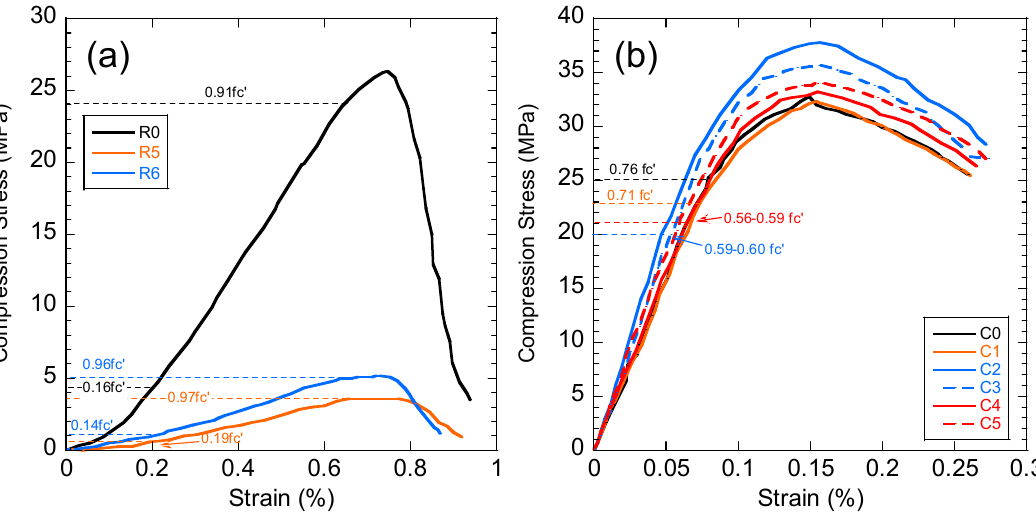
Figure 8. Stress-strain curve of ( a ) black shale and ( b ) concrete specimens after the immersion tests. C0 and R0 denote the concrete and black shale specimens before the immersion tests.